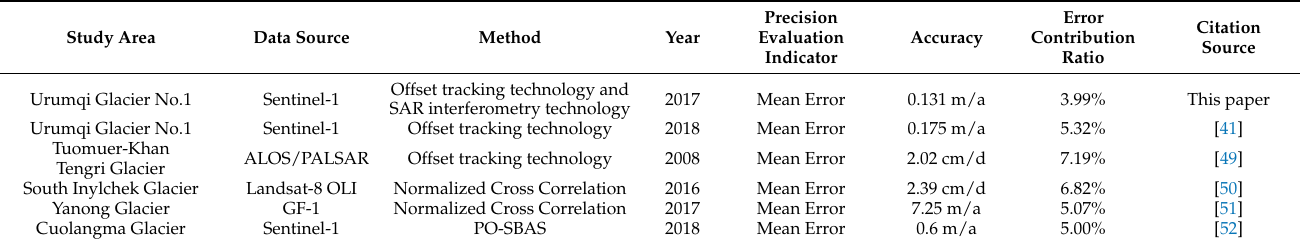
Table 3. Error comparison of different glacier velocity